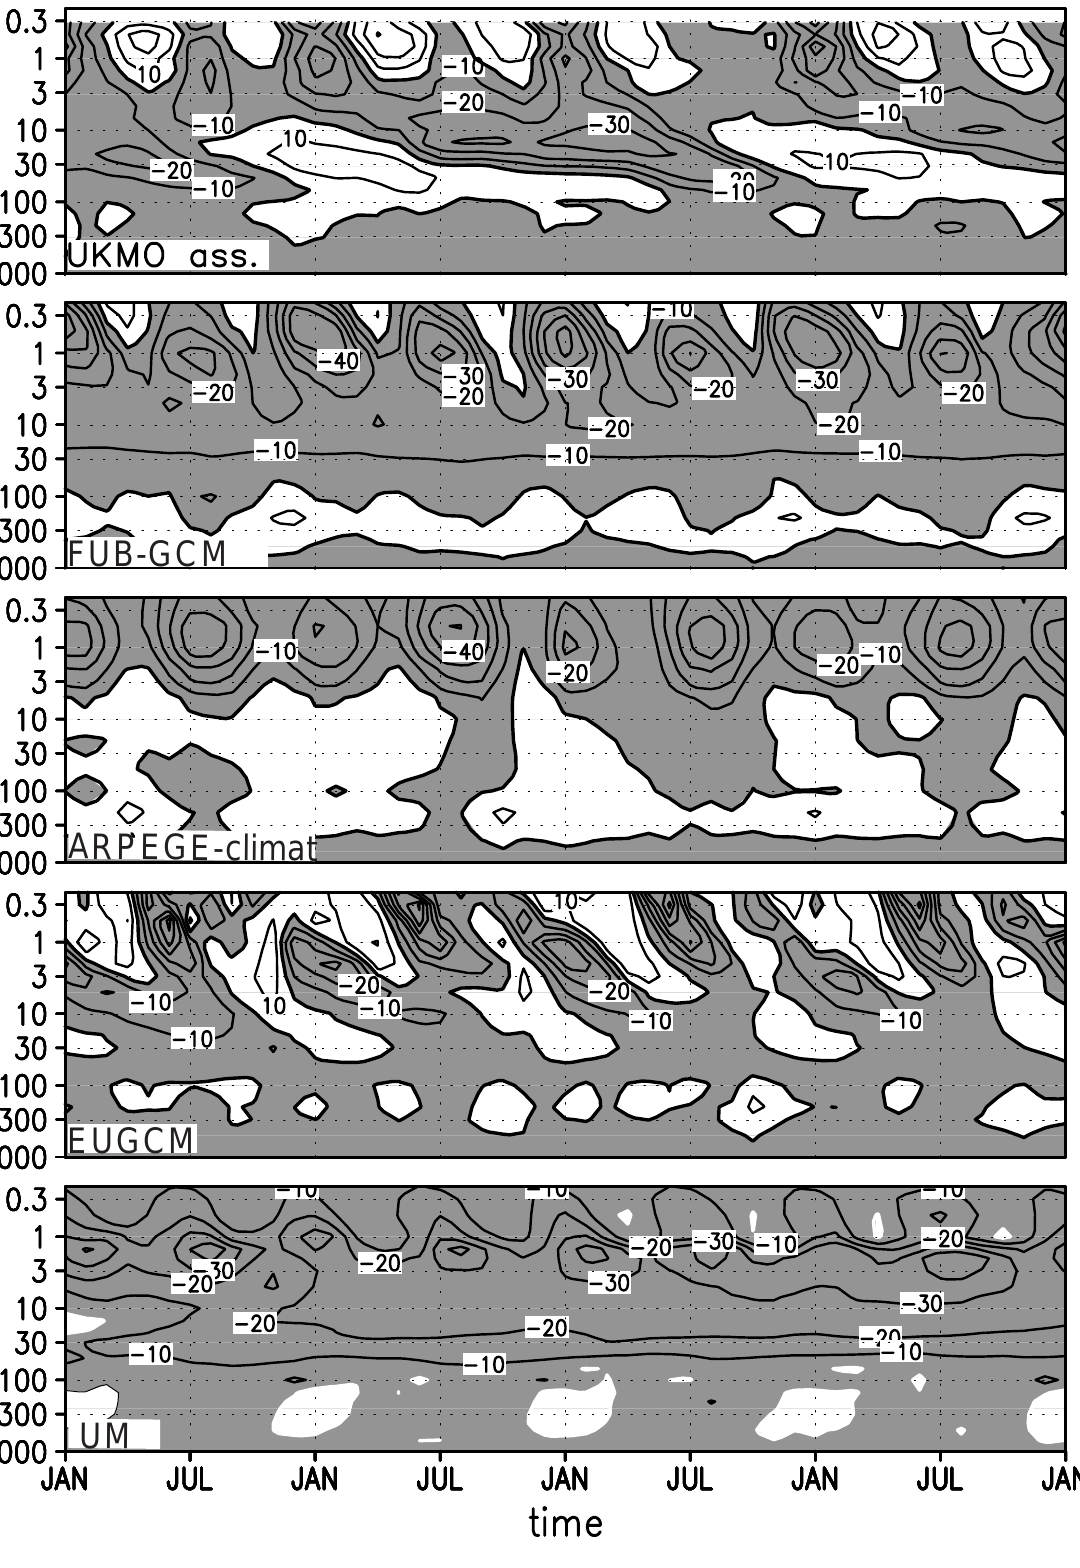
Fig. 2. Time series over four years of the zonal-mean zonal wind near the equator in the UKMO assimilated data and the FUB-GCM, ARPEGE-climat, EUGCM and UM models (top to bottom). Negative values (easterlies) are shaded and the contour interval is 10 m/s. The vertical axis extends from the surface to 0.2 hPa. The four selected years for the UKMO assimilated data are 1992 to